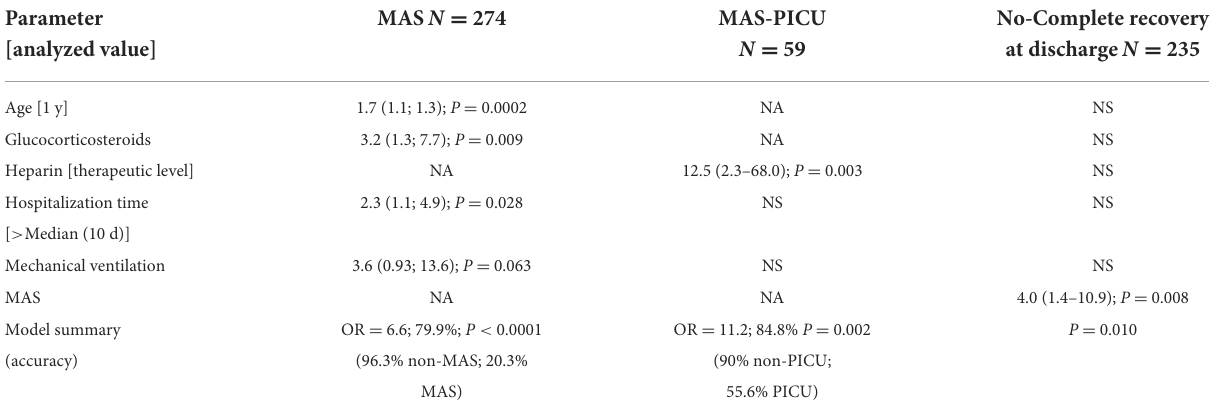
TABLE 4 Multivariable analysis of the influence of therapy on the presence of macrophage activation syndrome (MAS), MAS requiring pediatric intensive care unit hospitalization (MAS-PICU), and outcome in 274 patients meeting MIS-C